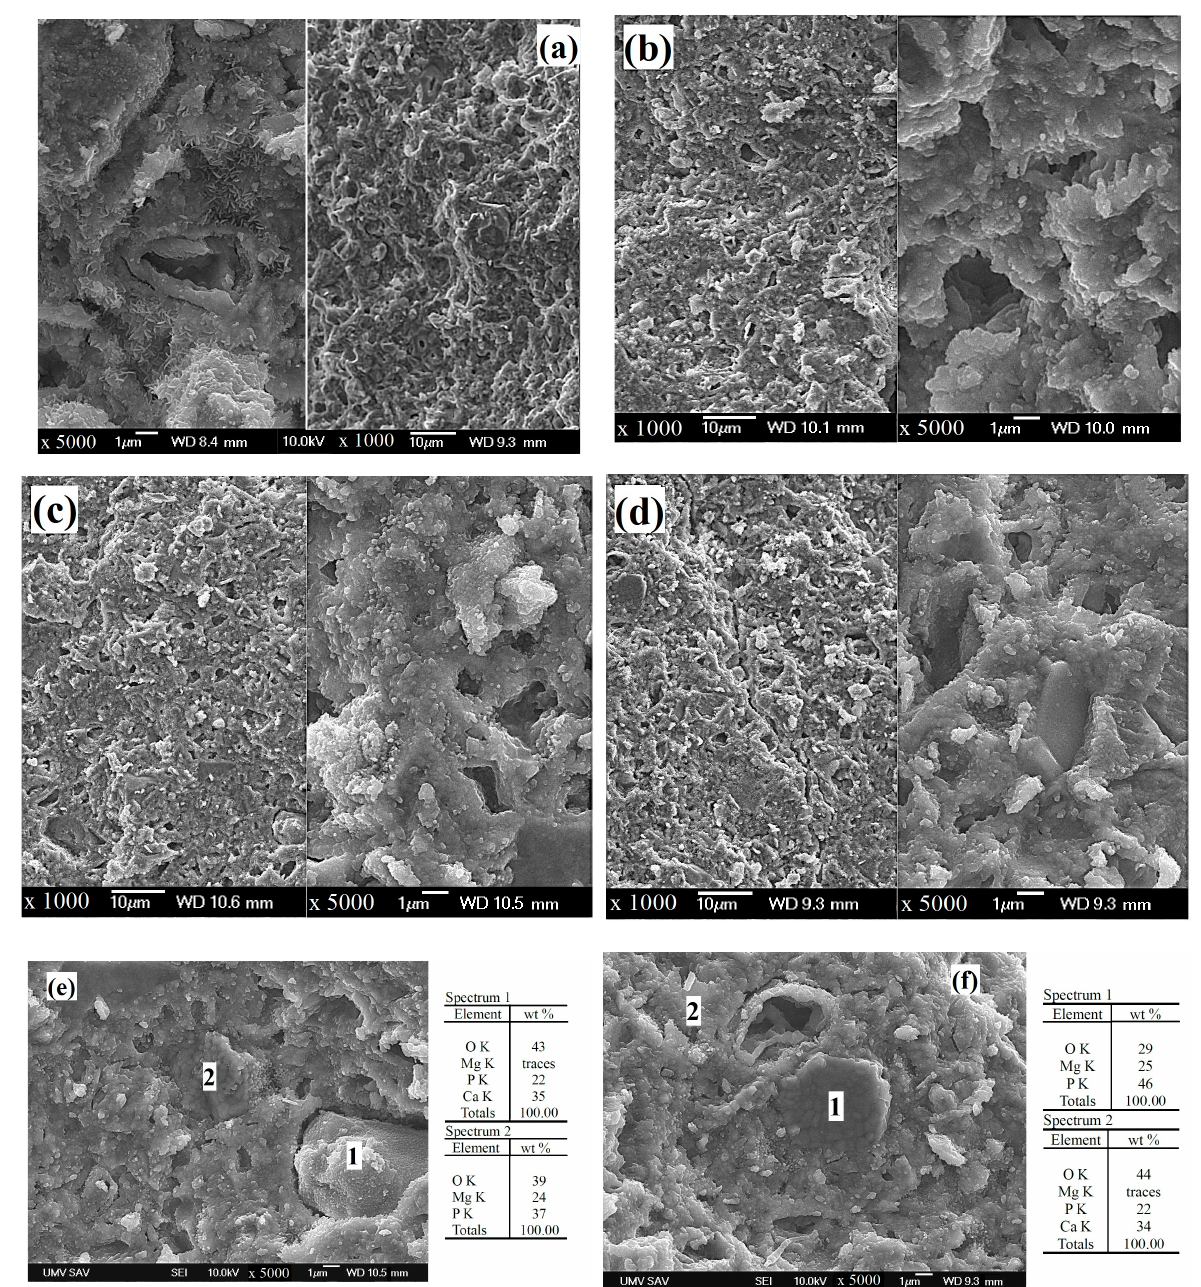
Figure 5. Microstructure of cements after 7 days of hardening in SBF at 37 °C: TTCPM ( a ), C1MP850 ( b ), C1MP1000 ( c ), C2MP1000 ( d ), EDX analysis of individual grains in C1MP1000 ( e ), and C2MP1000 ( f ) cements.